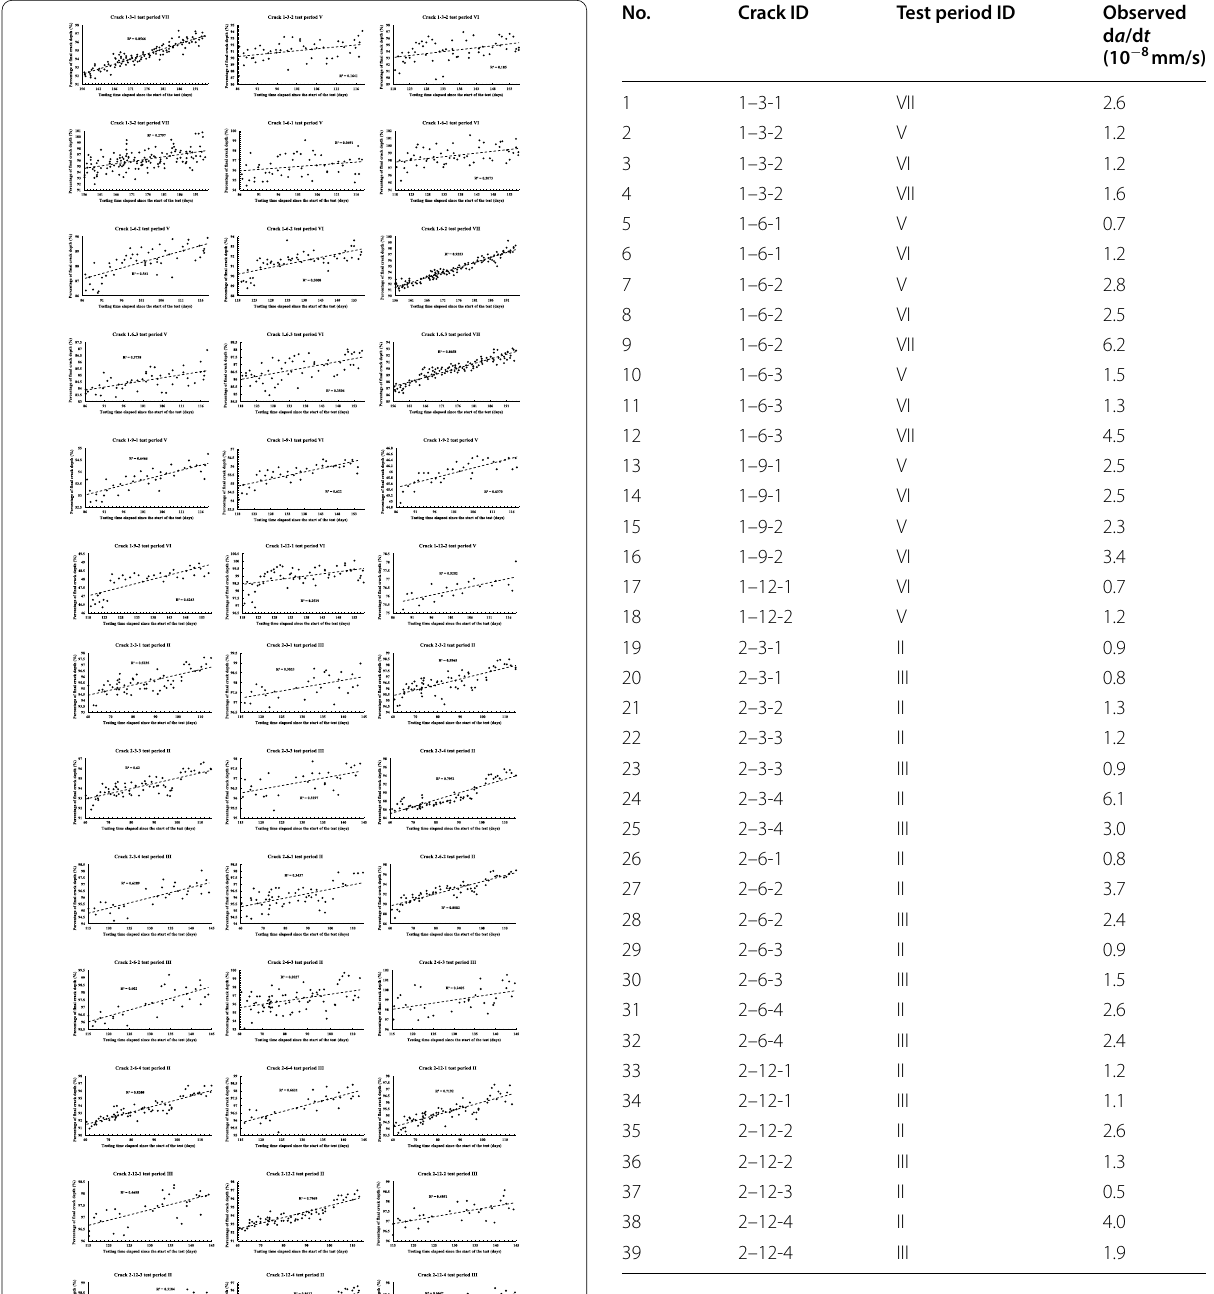
Table 7 1 Summary of 39 observed crack growth rates